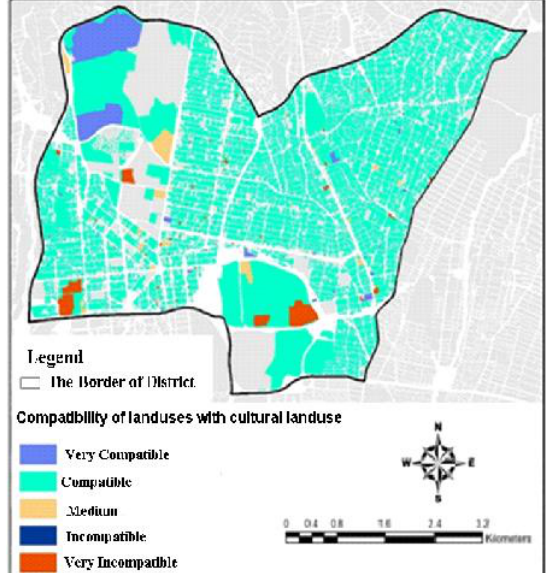
Compatibility of Land